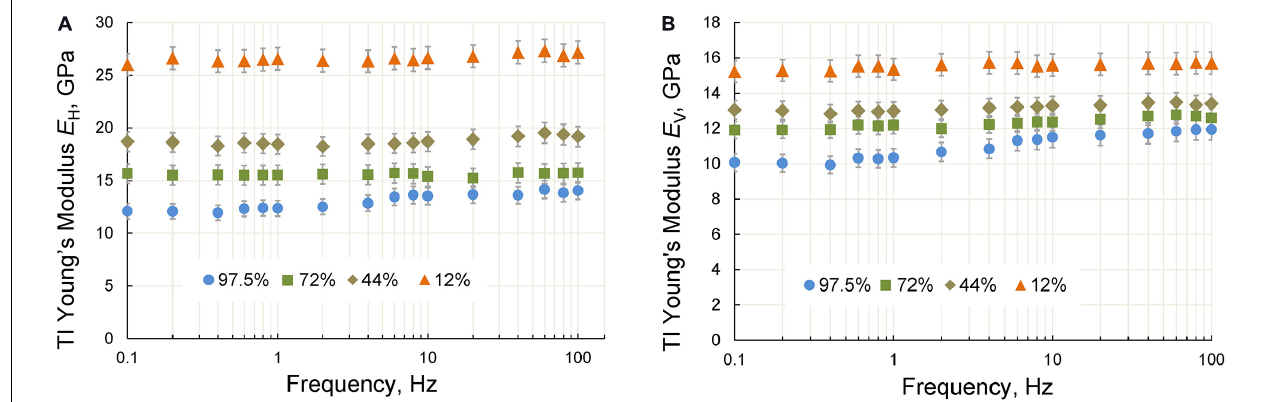
FIGURE 12 | The TI Young’s moduli measured on the horizontal (A) and vertical (B) shale samples saturated at relative humidity of 12, 44, 72, and 97% under a confining pressure of 6 MPa.